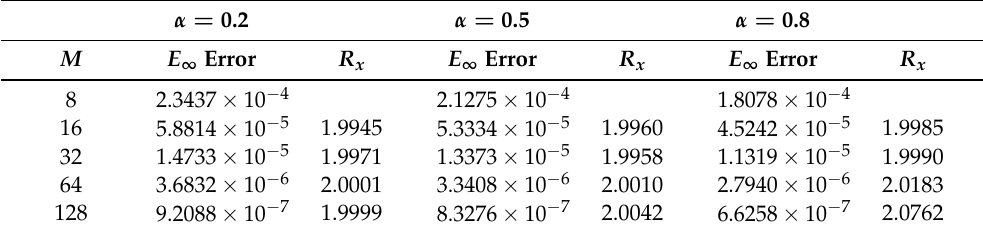
Figure 3. Numerical solutions of Example 2 with different choices of weight functions ω ( t ) and scale functions ζ ( t ) , and M = N = 200 with α = 0.9. Table 6. The maximum errors and convergence rates R x for Example 2, when τ = 1/500 with different α s.